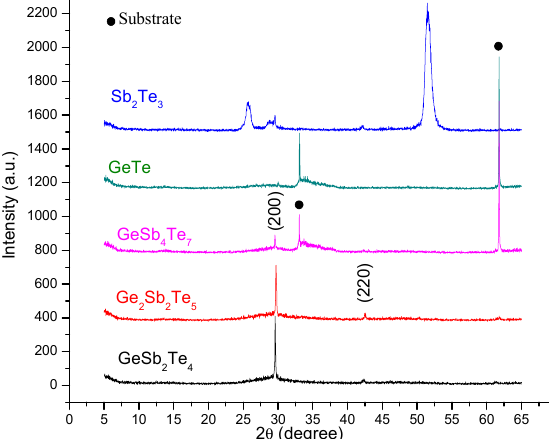
Figure 2. The XRD patterns of the chalcogenide thin films deposited using the 266-nm harmonic of the Nd-YAG laser.